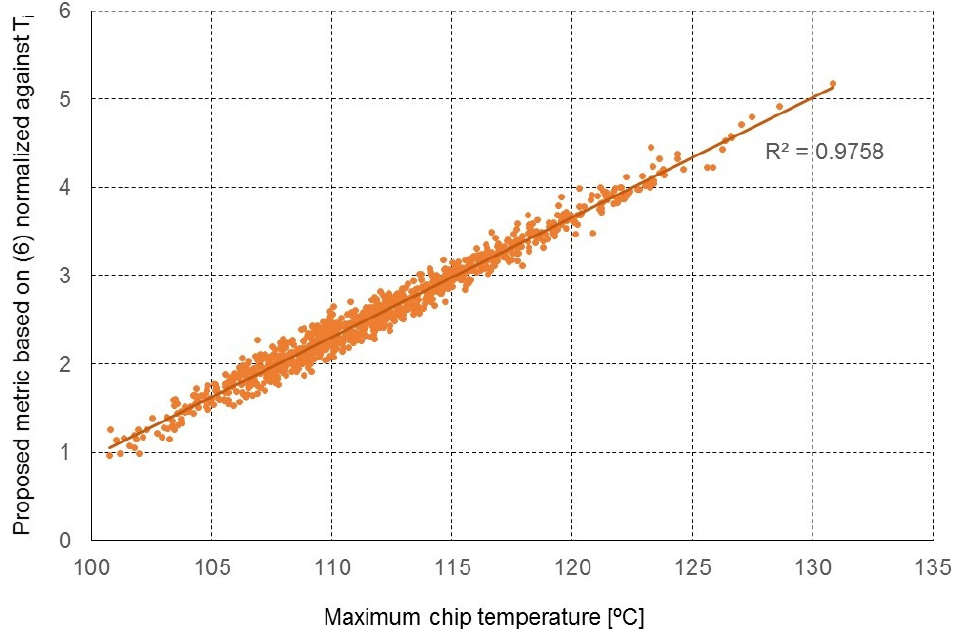
Figure 13. Simulation results of 1000 cases, showing the correlation between the metric proposed in this paper and the maximum chip temperature.